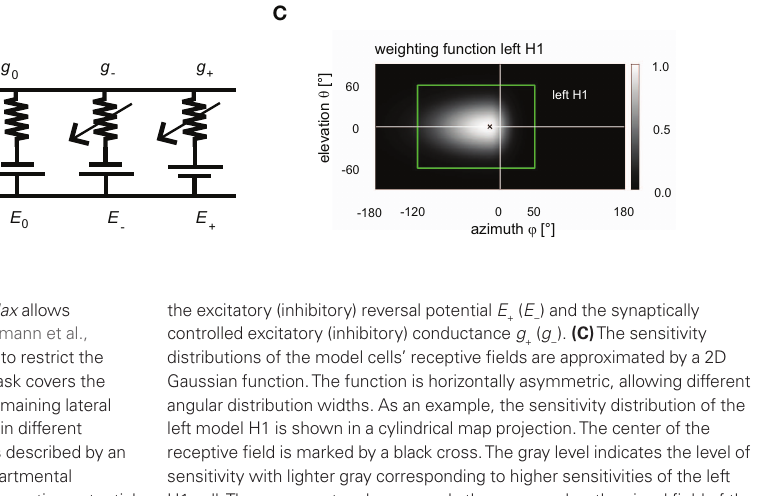
Figure 2 | (A) The panoramic visual stimulation device FliMax allows stimulation of ± 120 ° at the eye equator (for details see Lindemann et al., 2003). Three disjunct electronic masks were applied in order to restrict the visual input to defined regions of the visual field. A frontal mask covers the binocular visual field (yellow). Two further masks cover the remaining lateral parts of the visual field (green, red). The masks were applied in different combinations. (B) Dendritic integration of all modeled cells is described by an electrical equivalent circuit consisting of a passive one-compartmental membrane patch. The leakage currents are determined by the resting potential E and the leak conductance g . The excitatory (inhibitory) currents are given by 0 0